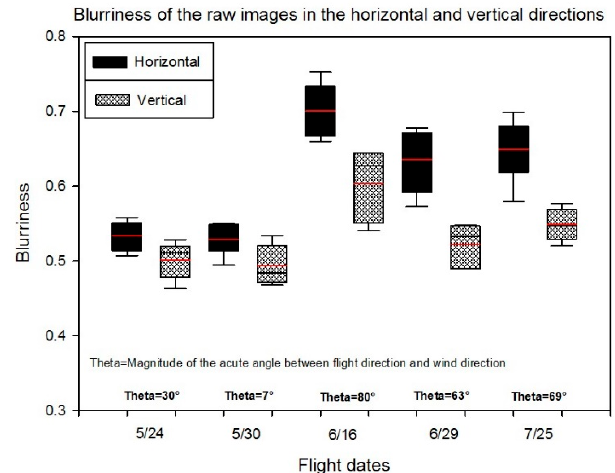
Figure 19. Blurriness of the raw images in the horizontal and vertical directions.